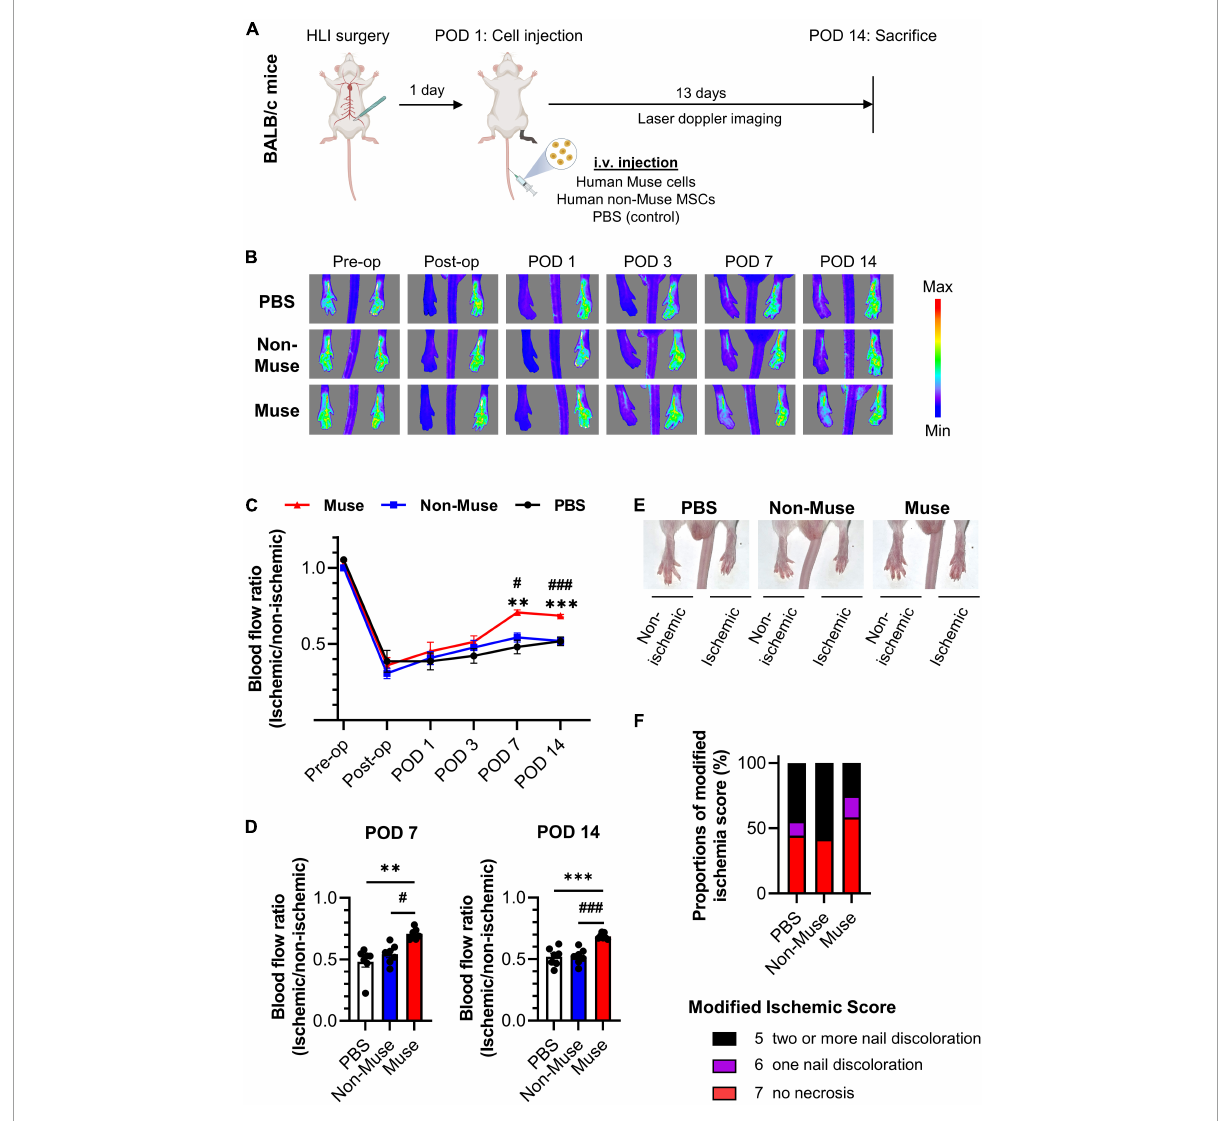
FIGURE1 Muse cell intravenous injection recovered blood flow in a mouse model of hindlimb ischemia. (A) Schematic outline of study workflow. Human-Muse cells, human-non-Muse mesenchymal stem cells (MSCs), or phosphate buffered saline (PBS, control) were administered via intravenous injection (i.v.) on postoperative day (POD) 1 after hindlimb ischemia (HLI) surgery. (B–D) Representative Laser Doppler blood perfusion images (B) and quantitative analysis of the ischemic/non-ischemic limb blood flow ratio over time (C,D) . The hindlimb blood flow ratio was measured before and after HLI surgery and on POD 1, 3, 7, and 14 ( n = 7 per each group; mean ± SEM). Dots correspond to each mouse. ∗∗ P < 0.01 PBS vs. Muse; ∗∗∗ P < 0.001 PBS vs. Muse; # P < 0.05 non-Muse vs. Muse; ### P < 0.001 non-Muse vs. Muse. (E,F) Representative images (E) and scores (F) of necrotic changes in hindlimb at POD 14 ( n = 9 in the PBS group, n = 11 in the non-Muse group, and n = 12 in the Muse group).